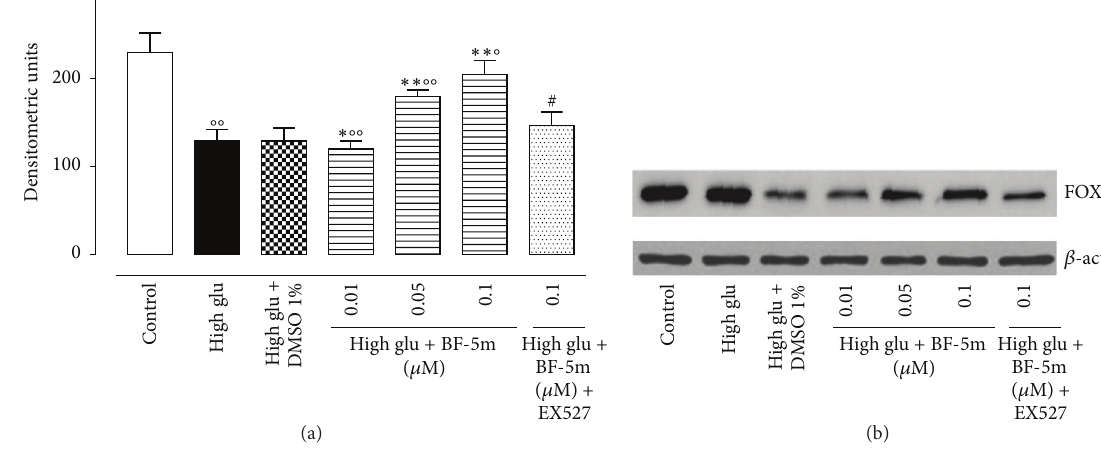
Figure5:(a)ExpressionofFOXO-1inheartsperfusedwithglucose11.1 mM(control);glucose11.1mM+DMSO1%(vehicle);glucose33.3 mM (high glu); high glu + BF-5m (0.01, 0.05, and 0.1 𝜇 M); high glu + BF-5m (0.1 𝜇 M) + EX527 (10mg/kg/day i.p.). Results are derived from western blotting (panel (b) representative) and expressed as densitometric units and represented the mean ± s.e.m. of 𝑛 = 10 observations for each group. Significant differences versus control are reported as ∘ 𝑃 < 0.05 and ∘∘ 𝑃 < 0.01 ; significant differences versus high glu are reported as ∗ 𝑃 < 0.05 and ∗∗ 𝑃 < 0.01 ; significant differences versus high glu + BF-5m 0.1 𝜇 M are reported as # 𝑃 < 0.01